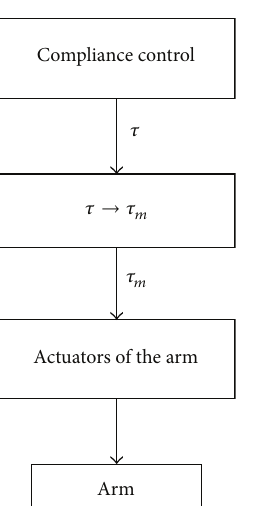
Figure 10: Functional architecture of the subsystem of the